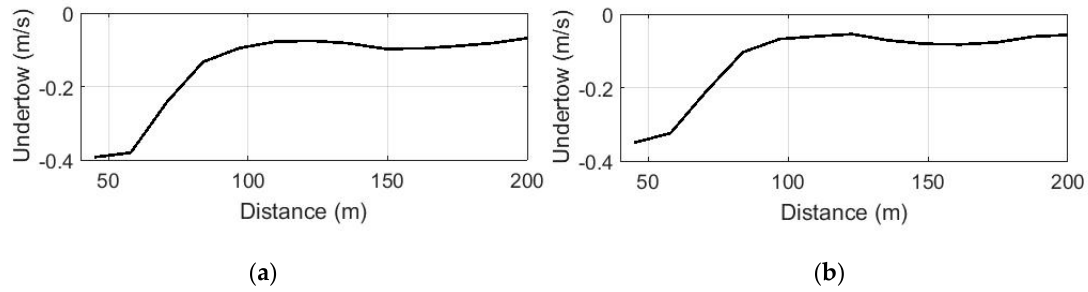
Figure 7. The undertow calculated on Formula (8) for mean wave regime (28 September) ( a ) and wave regime on the 29 September 2007 (morning) ( b ).